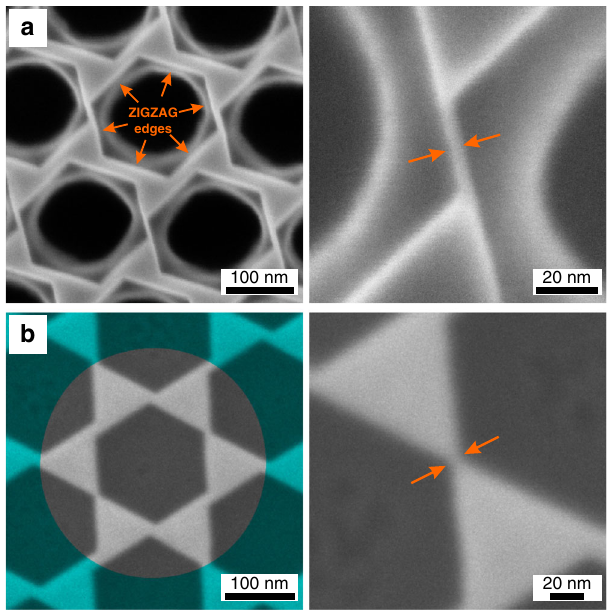
Fig. 4 Fabrication of a few-nanometer narrow nanoribbons and nanojunctions. a SEM images of a (left-panel) hexagonal hole array in WS 2 and a (right-panel) thin ( ∼ 3 nm) nanoribbon sandwiched between two zigzag-terminated edges. b SEM images of a (left-panel) hexagonal hole array in WS 2 resulting in bow-tie nanostructures and a (right-panel) thin nanojunction